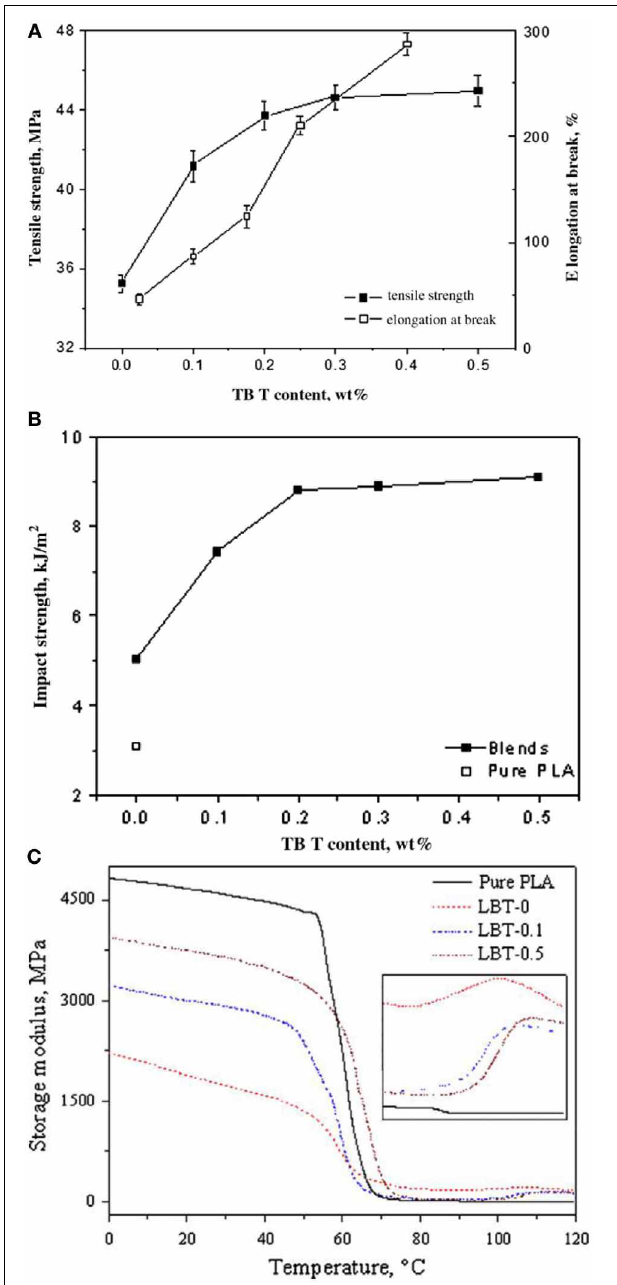
FIGURE 5 | (A) Effect of TBT concentrations on the tensile strength and elongation at break. (B) Variation of impact strength of PLA/PBAT blends with TBT concentration. (C) Temperature dependence of storage modulus of pure PLA and its blends [Reprinted from Lin et al. (2012) with permission from